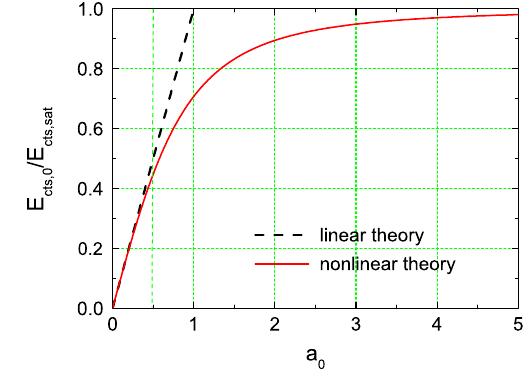
FIG. 6. Saturation effect of nonlinear CTS [Eq. (30)].